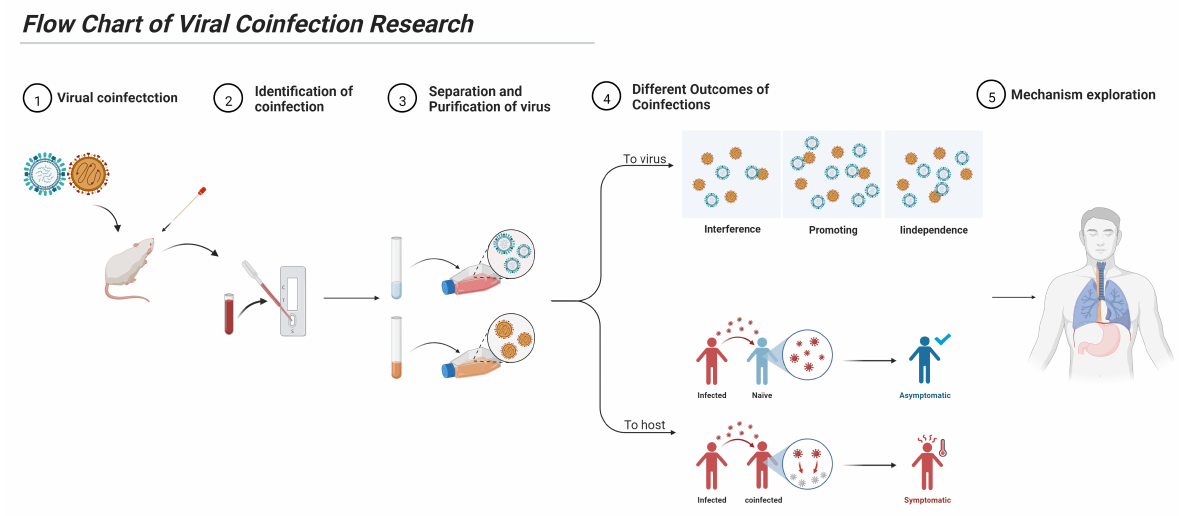
Figure 3. Flow chart of viral coinfection research. For the study of viral coinfection, it is necessary to correctly identify the occurrence of coinfections, establish a corresponding coinfection virus isolation and detection system, and determine the type of viral coinfection and its effect on a host. Finally, the mechanism of viral coinfection can be